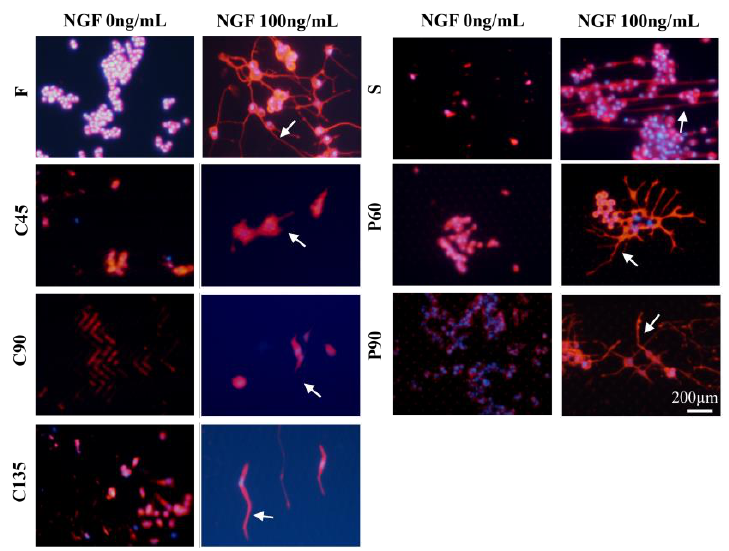
Figure 3. Fluorescence images of β -tubulin expression of PC12 cells under different conditions. Red, β -tubulin; blue, cell nucleus; NGF:100 ng/mL; Scale bar = 200 µm.